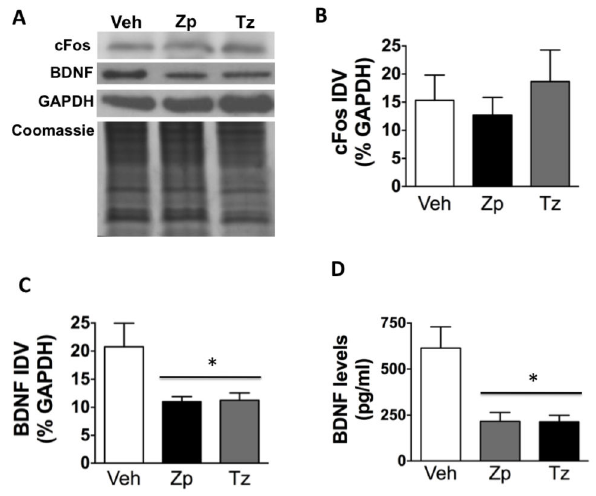
treatment. (A) Representative immunoblots for c-Fos,